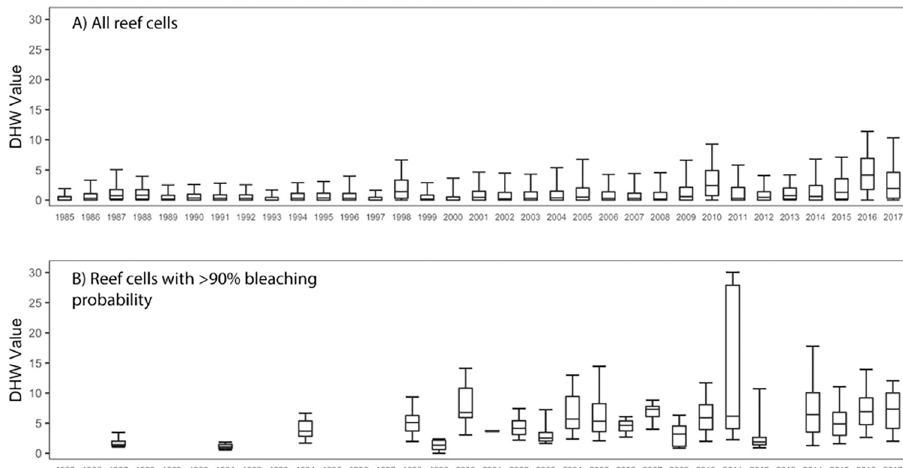
Fig 5. Median, quartile range, and 5th and 95th percentile of annual maximum DHW of a) all reef cells and b) reef cells with a bleaching probability above 90% 1985–2017.